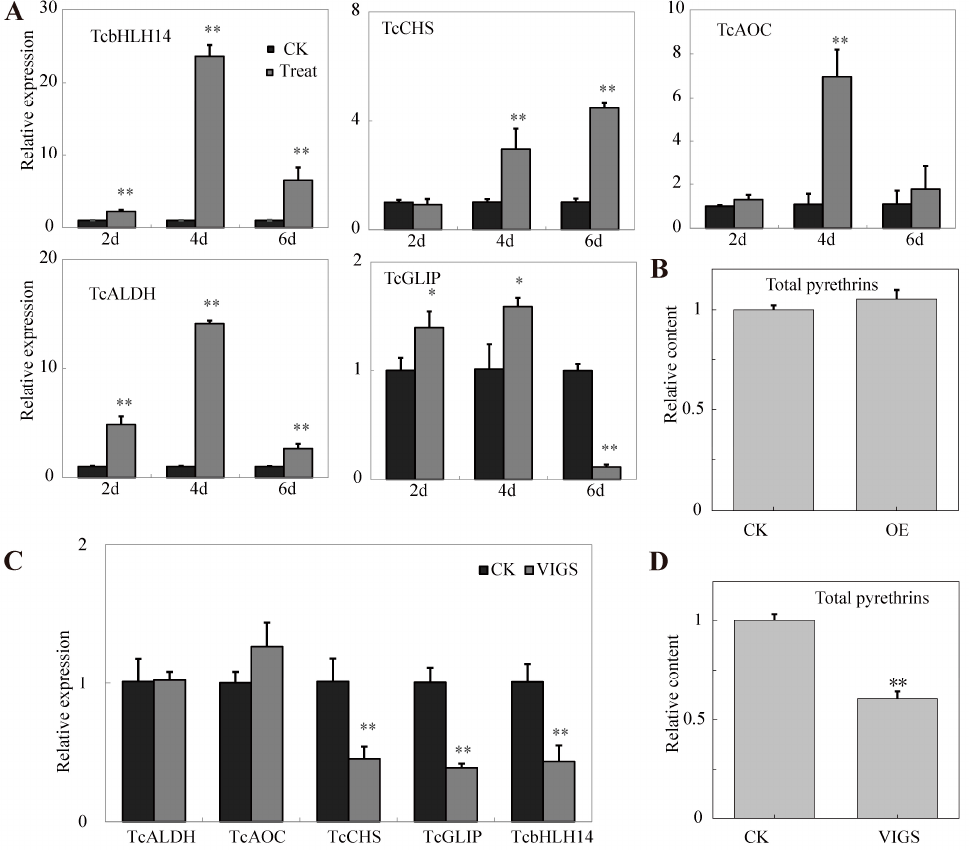
Figure 5. Determination of pyrethrin biosynthesis-related gene expression and pyrethrin content in the leaves with transient overexpression and silencing of TcbHLH14 . ( A ) Expression levels of TcGLIP , TcALDH , TcAOC , TcCHS , and TcbHLH14 genes in pyrethrum leaves after transient overexpression of TcbHLH14 for 2, 4, and 6 days. ( B ) After transient overexpression of TcbHLH14 for 4 days, the content of total pyrethrins in the leaves was measured. ( C ) Expression levels of TcGLIP , TcALDH , TcAOC , TcCHS , and TcbHLH14 genes in the leaves after transient VIGS silencing of TcbHLH14 . ( D ) Content of the total pyrethrins in the leaves after transient silencing of TcbHLH14 . Data are presented as means ± SD of three technical replicates. Statistical significance was assessed with Student’s t -test (** p < 0.01; * p <